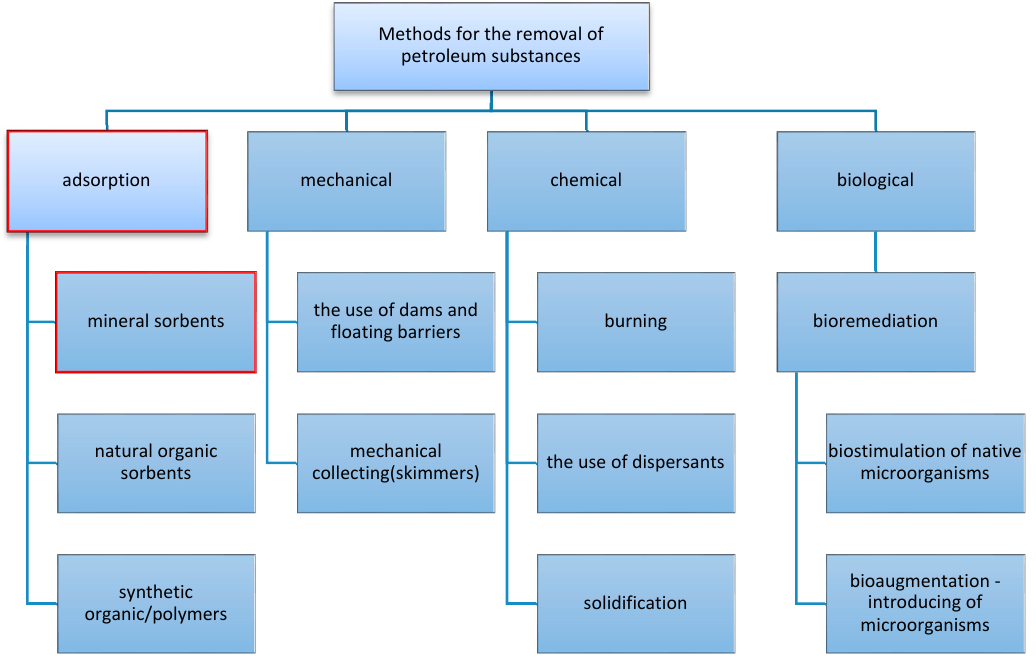
Figure 1. Methods used for the petroleum substance removal.